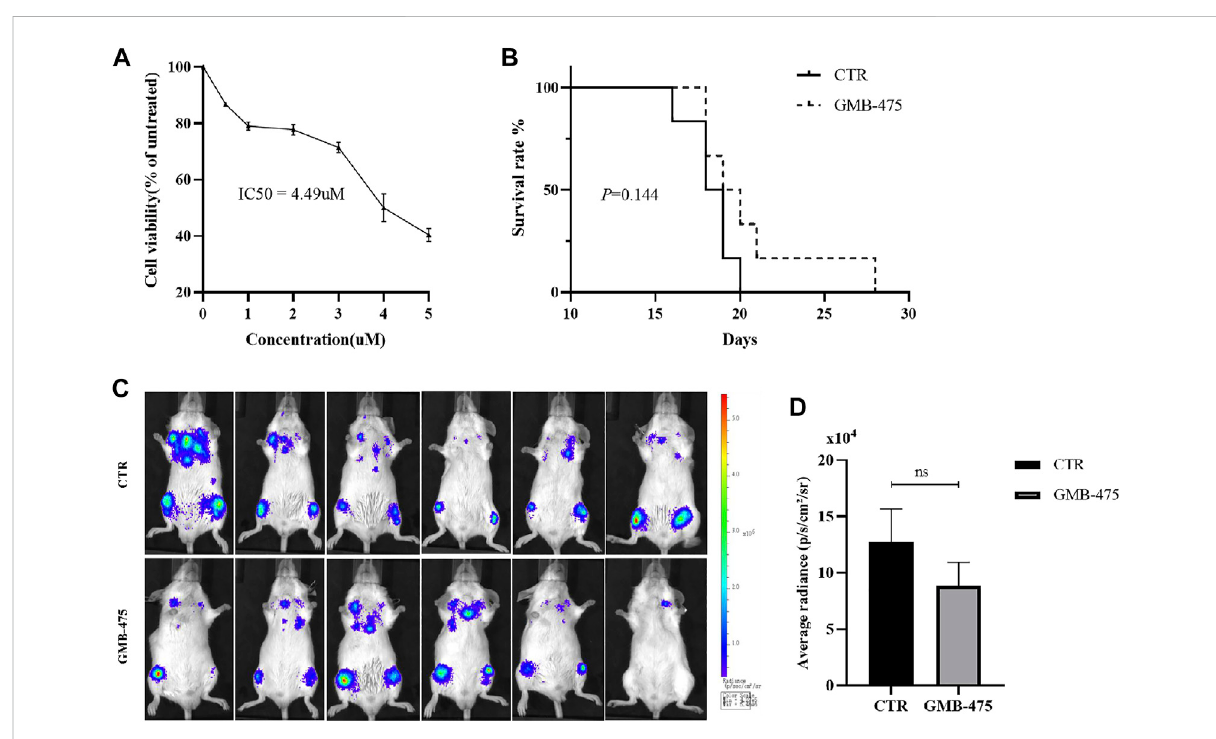
GMB-475exhibited agrowth inhibition effect on Ba/F3-MIG-p210 cells carryingBCR::ABL1 T315I+F486S mutations but no signi fi cantimprovement of prognosis in the CML mouse model constructed by this cell line. (A) Ba/F3-MIG-p210 cells carrying BCR::ABL1 T315I+F486S mutations were treated with different concentrations of GMB-475 for 48 h, and cell viability was detected using the CCK8 assay. (B) Survival curve of the CML mouse model for the control group and the GMB-475 administration group. (C) Fluorescence imaging of CML mouse model was implemented at day 9.